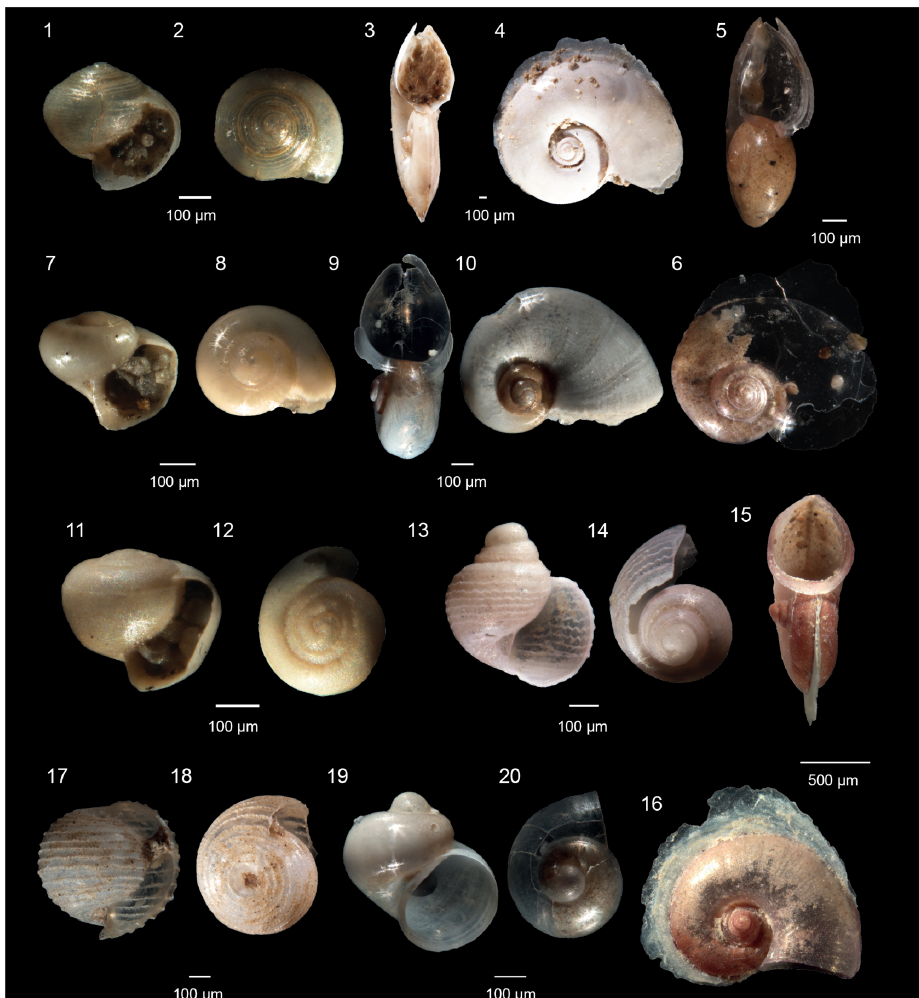
Figure 4. Heteropoda from the Levantine Basin (offshore of Israel). (1)–(4) Atlanta selvagensis (de Vera and Seapy, 2006), (1)–(2) juvenile specimens, (1) aperture view, (2) spiral view; (3)–(4) adult specimens, (3) aperture view, (4) spiral view; (5)–(6) Atlanta helicinoidea (Gray, 1850), (5) aperture view, (6) spiral view; (7)–(10) Protatlanta souleyeti (Smith, 1888), (7)–(8) juvenile specimens, (7) aperture view, (8) spiral view; (9)–(10) adult specimens, (9) aperture view, (10) spiral view; (11)–(12) Atlanta rosea (Gray, 1850), (11) aperture view, (12) spiral view; (13)–(16) Atlanta turriculata (d’Orbigny, 1835), (13)–(14) juvenile specimens, (13) aperture view, (14) spiral view, (15)–(16)